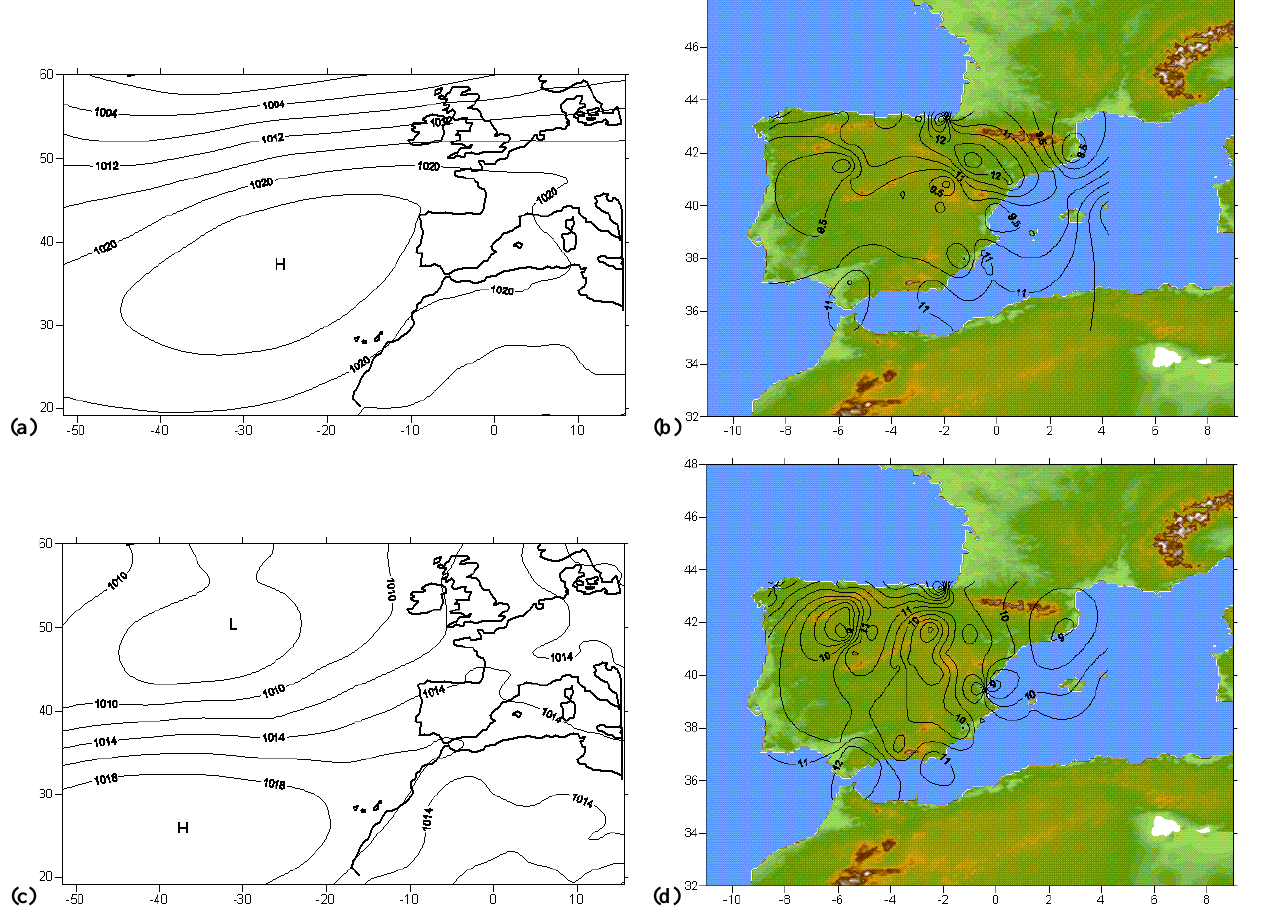
Fig. 7. Same as Fig. 6 except for the second